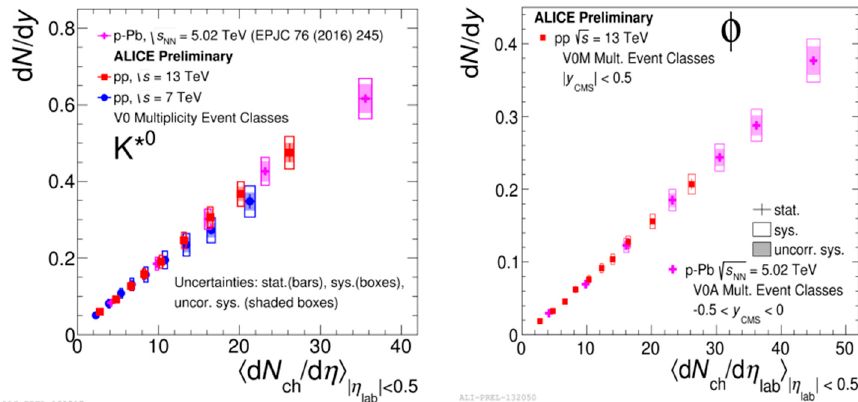
Figure 1. Integrated yield of K*(892) 0 as a function of the mean charged-particle multiplicity density for pp collisions at √𝒔 = 7, 13 TeV and p-Pb collisions at √𝒔 𝐍𝐍 = 5.02 TeV ( left panel ). Integrated yield of φ (1020) as a function of the mean charged-particle multiplicity density for pp collisions at √𝒔 = 13 TeV and p-Pb collisions at √𝒔 𝐍𝐍 = 5.02 TeV ( right panel ). Statistical and systematic uncertainties are plotted as vertical error bars and boxes, respectively. The shaded boxes are the multiplicity uncorrelated systematic uncertainties.